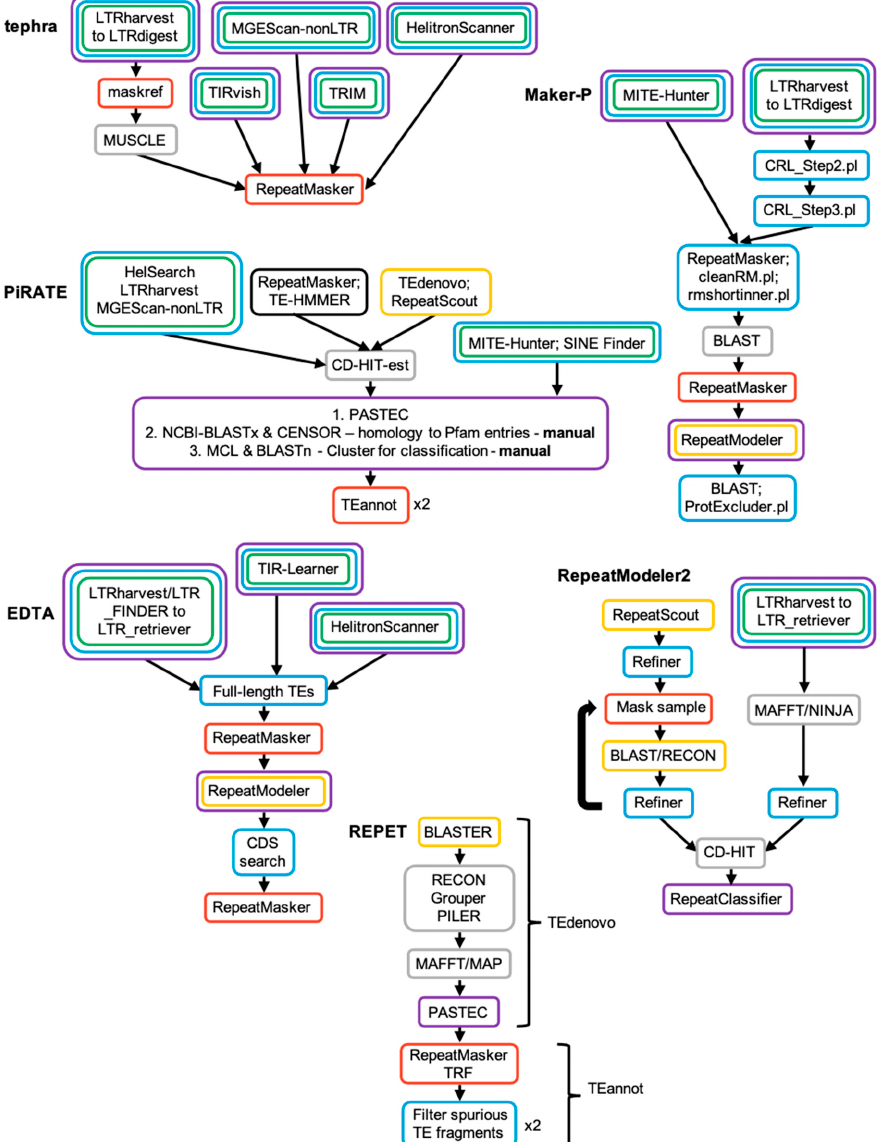
Figure 6. Workflow of select TE discovery pipelines. Each process in the pipeline has been categorized as classification (purple), signature-based TE detection (green), De Novo TE detection (gold), homology-based detection (black), genome annotation (red), filter and/or refinement (blue) and clustering (grey). Arrows indicate the general workflow direction. NOTE: the above image is meant to describe the high-level organization of each pipeline, and does not reflect the inherent complexity contained within. Refer to Supplementary Materials for additional details. Integrating a variety of tools into a single pipeline is an effective way to overcome the shortcomings of any one particular approach; however, it also introduces its own set